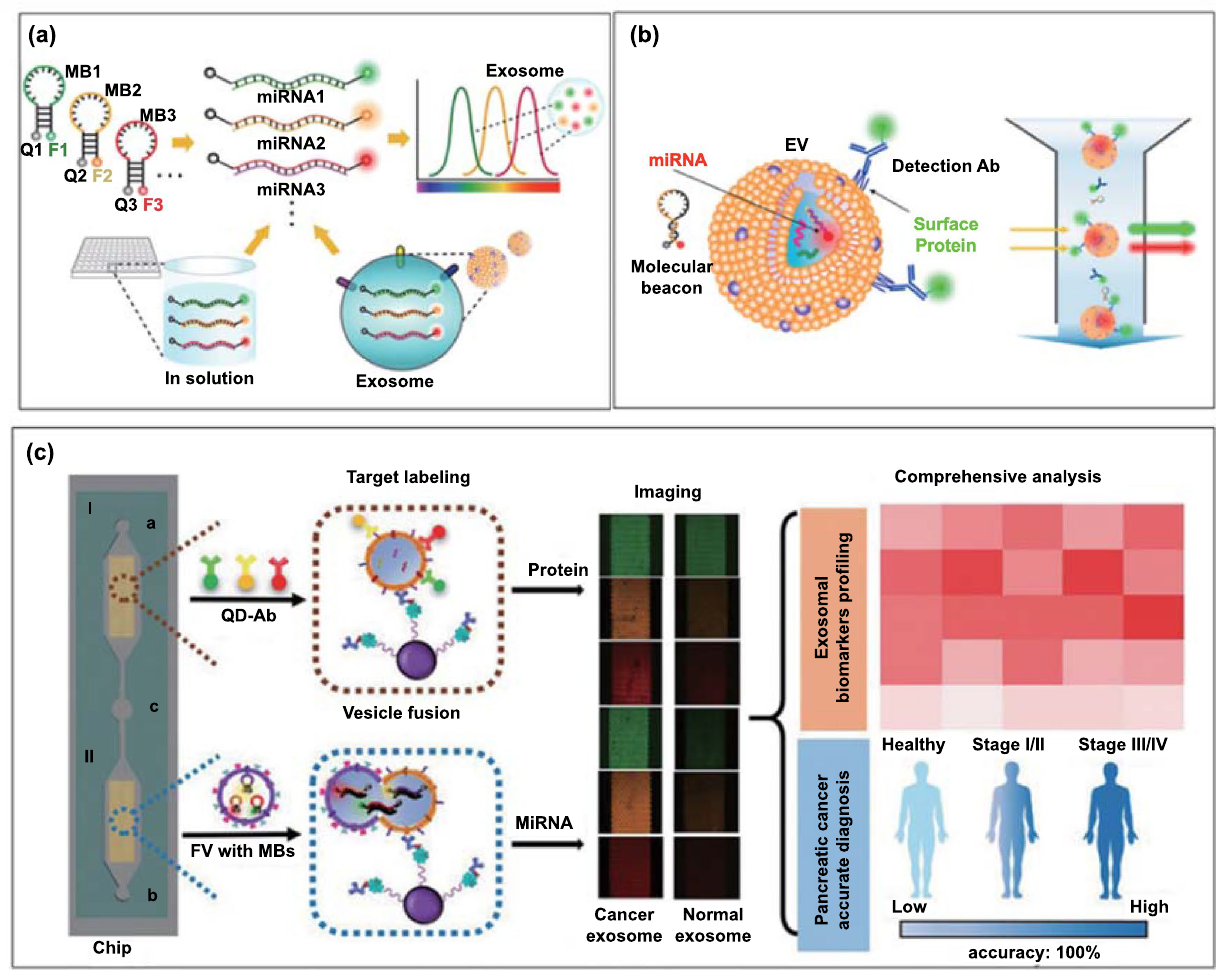
Fig. 6 a Molecular beacon-based exosome internal RNA triplexing ( F : fluorescent dye. Q : quencher). Reproduced with permission from Ref. [74]. Copyright 2016 Elsevier. b Simultaneous in situ detection of EV membrane protein and internal miRNA using dye conjugated molecular beacons and dye conjugated antibodies, respectively. Reproduced with permission from Ref. [76]. Copyright 2021 MDPI. c Simultaneous in situ detection of exosomal protein markers (CD81, ephrin type-A receptor 2, carbohydrate antigen 19–9) and miRNAs (miRNA-451a, miRNA-21, miRNA-10b) using QDs labelled antibody and molecular beacons using fusogenic vesicles in a microfluidic device. Reproduced with